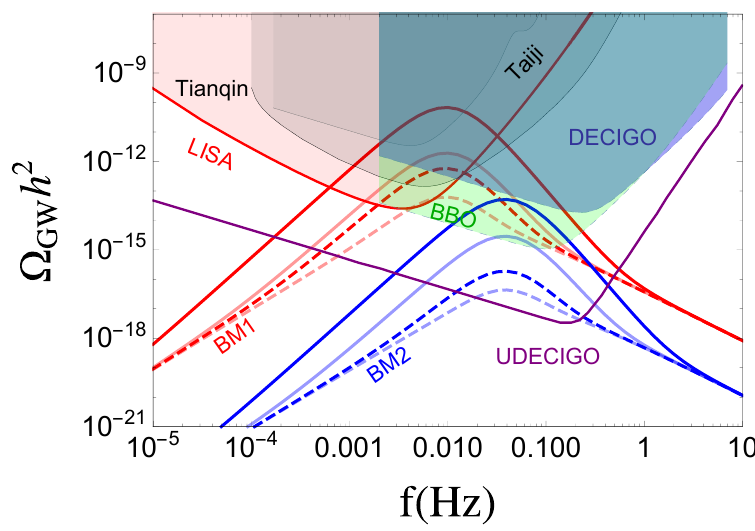
Figure 9. Gravitational wave energy spectrum versus the frequency for our two benchmark points and experimental sensitivities of some GW detectors. The lighter lines show the corresponding spectrum with the suppression factor Υ . The dashed lines show the spectrum beyond the bag